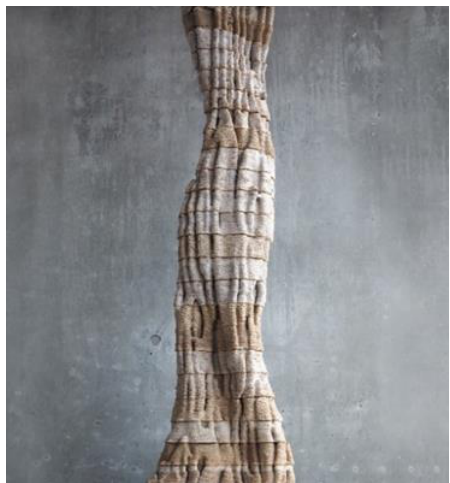
Figure 5. Protomycokion column. Photo by author.